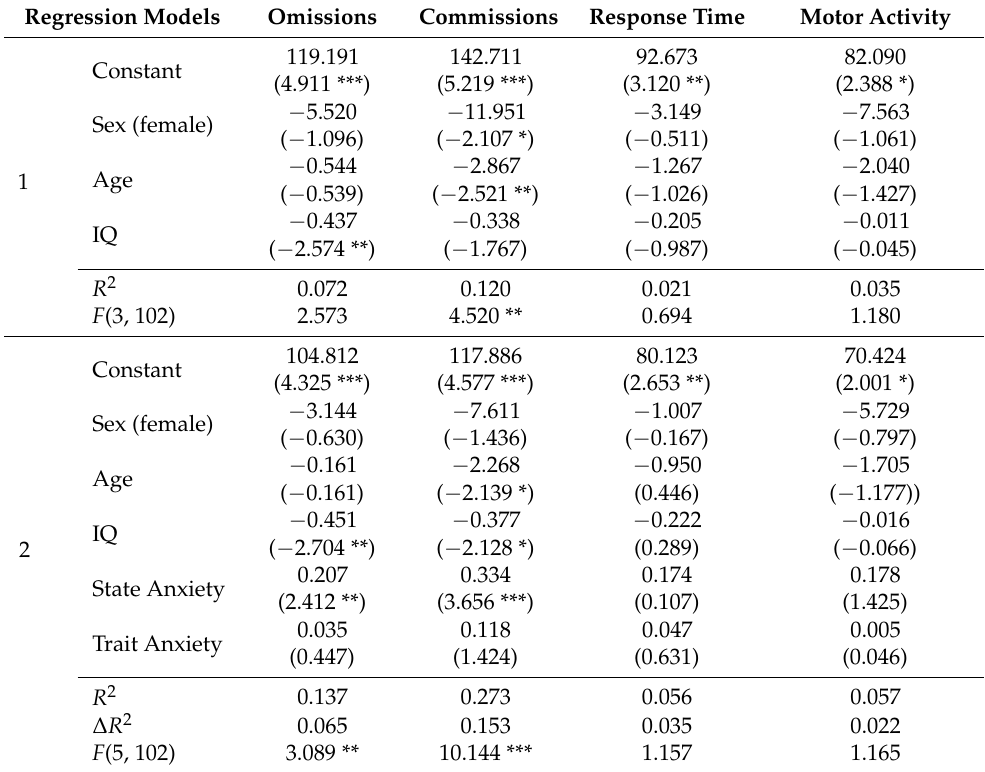
Table 3. Hierarchical regression models for predicting attentional variables from VR continuous performance